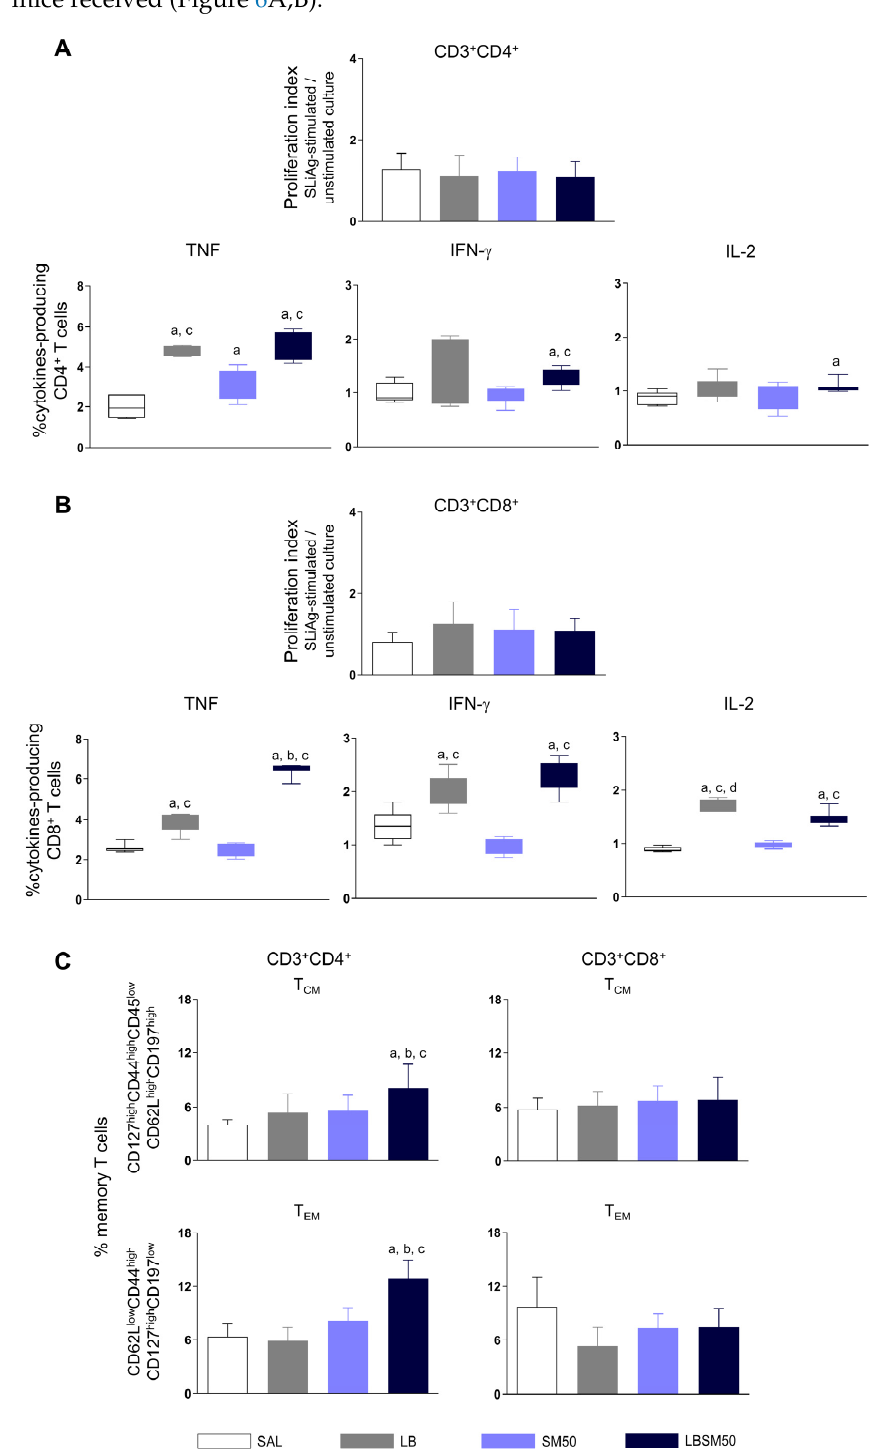
Figure 6. T lymphocytes proliferation, intracellular cytokine production, and memory T cells induced 1 by immunization and challenge with L. (L.) infantum in BALB/c mice ( n = 10/group). Proliferation index of CD4 + ( A ) and CD8 + ( B ) T cells obtained by the SLiAg-stimulated culture/unstimulated culture ratio. Intracellular cytokines-producing CD4 + ( A ) and CD8 + ( B ) T cells, and central and